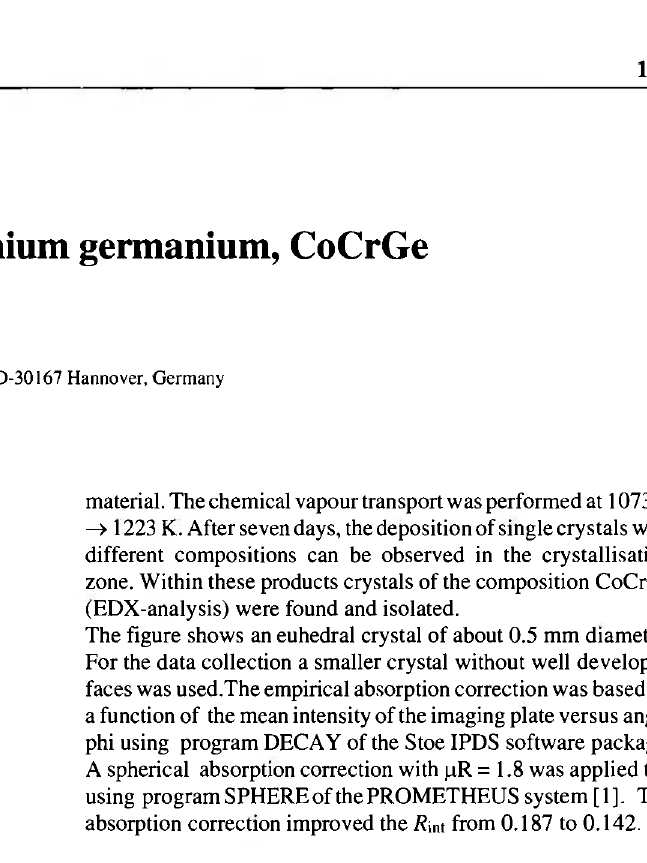
Fig. 1. A single crystal of CoCrGe.